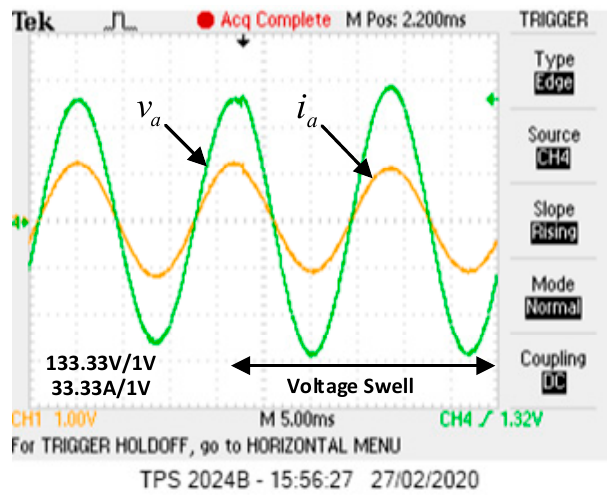
Figure 23. Voltage and current for phase A during a swell in the grid voltage from 120 to 132 Vrms.